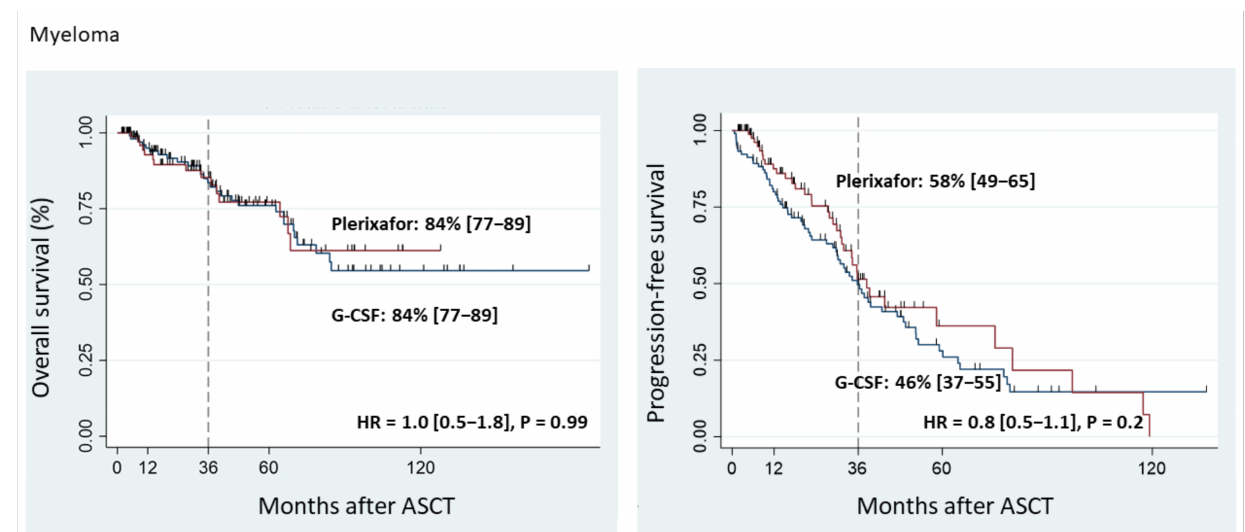
Figure 1. Overall survival and progression-free survival of myeloma patients. The 3-year PFS in myeloma patients requiring Plerixafor was 58% (95% CI, 49–65%) vs. 46% (95% CI, 37–55%) in the G-CSF Group ( p = 0.2) (Figure 1). The 3-year OS in lymphoma patients was 71% (95% CI, 59–80%) in the Plerixafor Group and 84% (95% CI, 76–89%) in the G-CSF Group ( p = 0.1) (Figure 2).